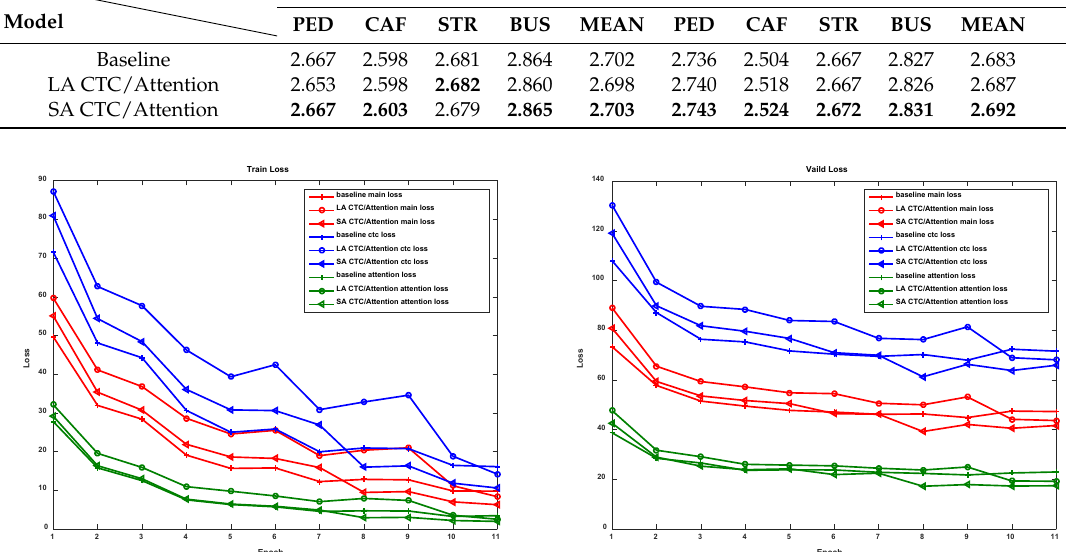
Figure 4. The train and valid loss of the baseline, LA CTC/Attention and SA CTC/Attention architectures for